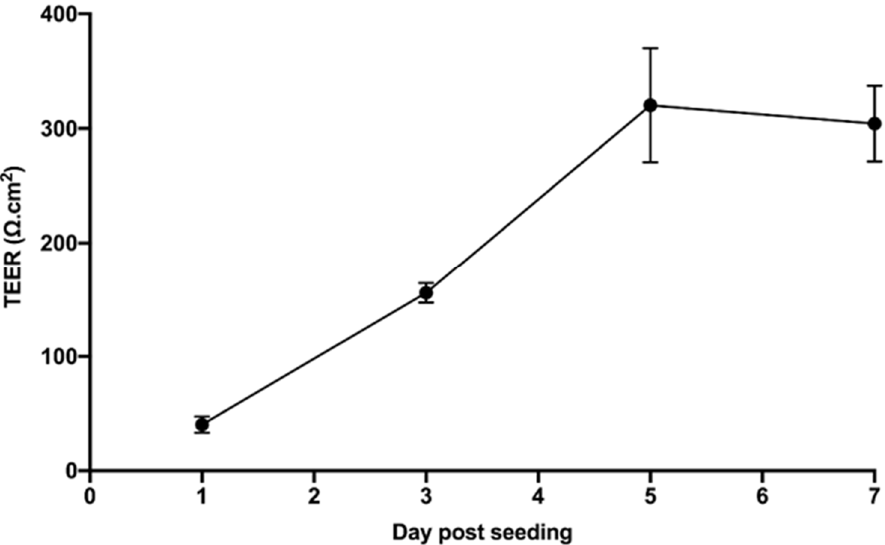
Figure 1. Mean TEER of hCMEC/D3 cell monolayers grown on 3.0 µ m Transwell ® inserts on days 1, 3, 5 and 7 post cell seeding.